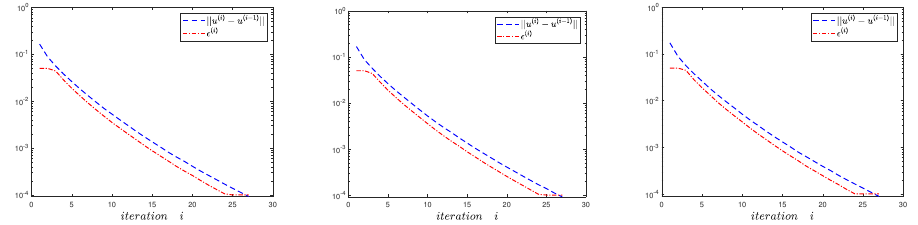
Figure 2. The changing process of (cid:101) ( i ) and || u ( i ) − u ( i − 1 ) || L 2 [ 0, T ] with iteration number i (Left: σ = 0.05. Middle σ = 0.1. Right: σ = 0.2).